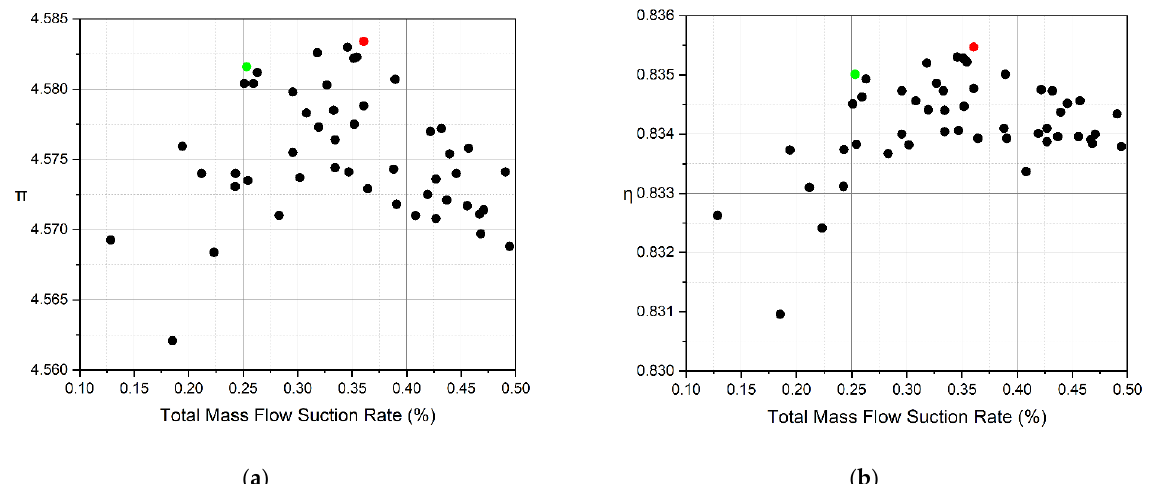
Figure 7. Results of the DOE study, (Blue: Sample Points, Red: O.F.R. Flow Control 1, Green: O.F.R. Flow Control 2): ( a ) pressure ratio, π ; ( b ) adiabatic efficiency, η . Table 3. Numeric results of the suction flow control study for operation flow rate. Energies 2022 , 14 , x FOR PEER REVIEW 10 of 13